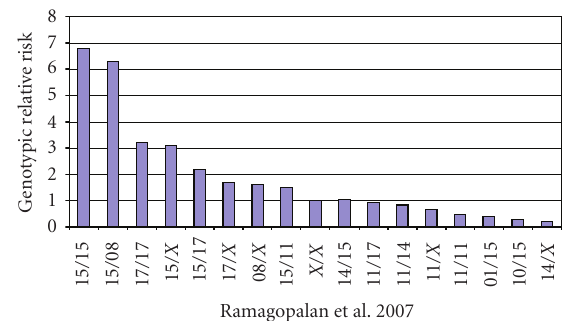
Figure 1: The relative risk of MS is determined by trans epistasis between di ff erent HLA-DRB1